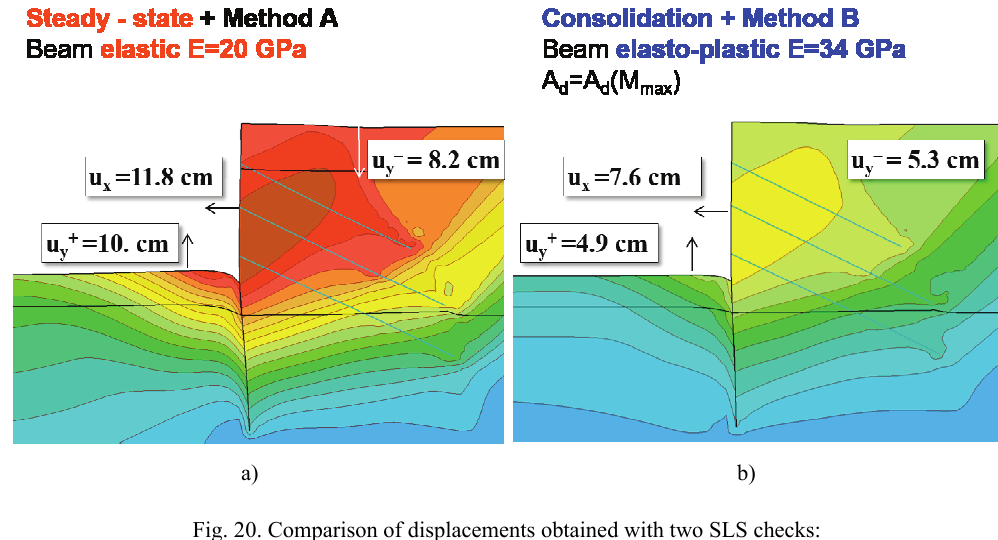
Fig. 20. Comparison of displacements obtained with two SLS checks: (a) steady-state analysis with elastic beam ( E c = 20 GPa), and (b) “genuine” SLS verification combining consolidation and non-linear structural analysis